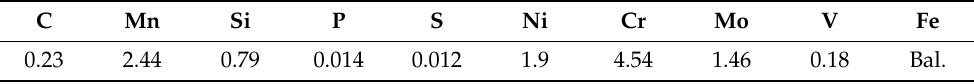
Table 2. Chemical composition of ferrous welding materials RMD142 used in this study, mass/%.